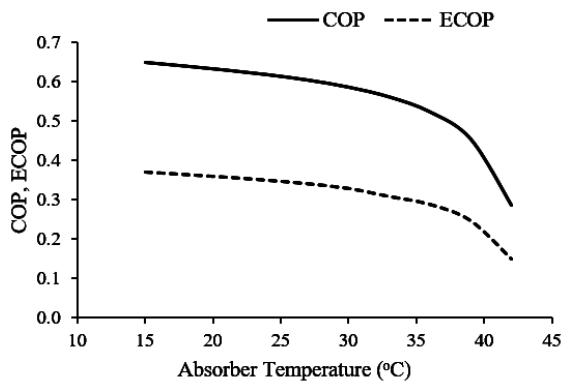
Figure 25. Effect of absorber temperature on COP and ECOP.